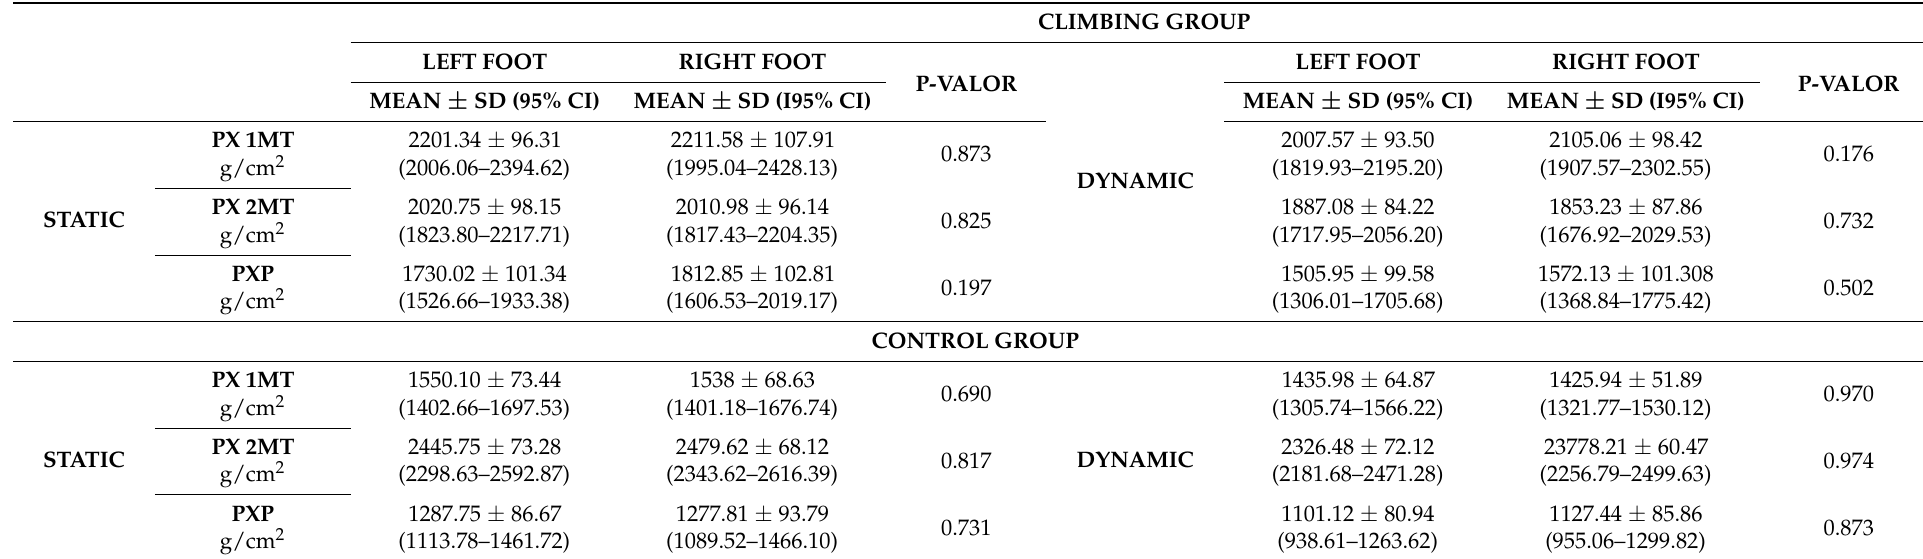
Table 2. Mean maximum pressure in the study population by study groups and different foot.